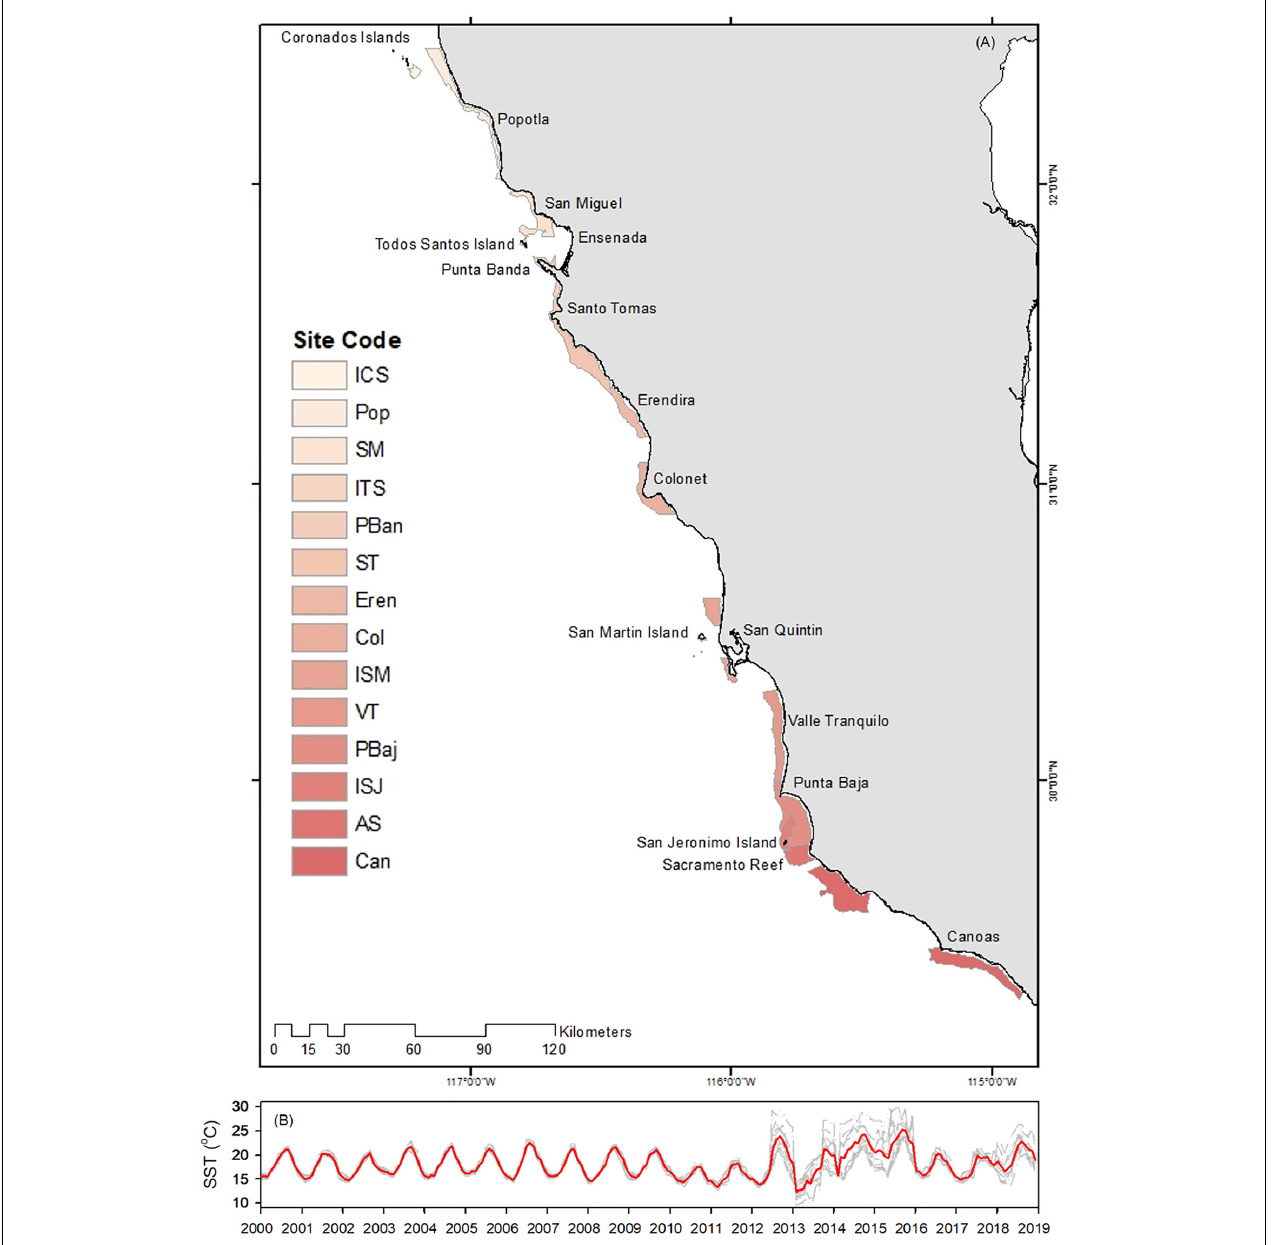
FIGURE 1 | Depth delimited authorized fishing areas for red sea urchin (A) , and SST time series profile (B) for each site (gray line) and average (red line). The color bars were used to separate sites only. Sea surface temperature was used to estimate natural mortality. Note the wide variations among sites in SST from 2012 to